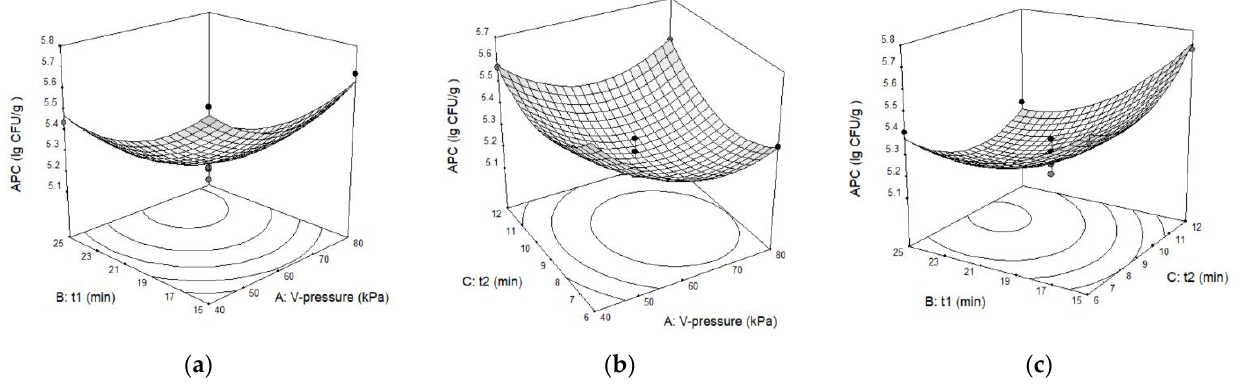
Figure 1. Three-dimensional response surface graphs for aerobic plate counts (APC) as a function of ( a ) p v and t 1 . ( b ) p v and t 2 ( c ) t 1 and t 2 .